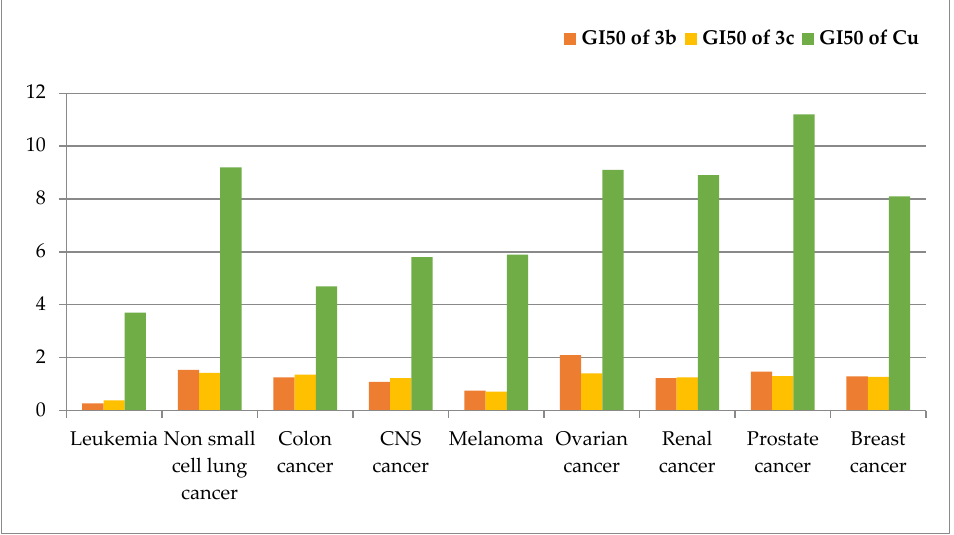
Figure 2. The mean GI 50 (in µM) for curcumin (Cu) and curcumin analogues 3b and 3c . Table 3. 60 NCI cancer cell lines-based antiproliferative activity of curcumin analogues 3a–c in sin- gle dose (10 µM) and 5-dose assay (0.001–100 µM) of curcumin analogues 3b–c .